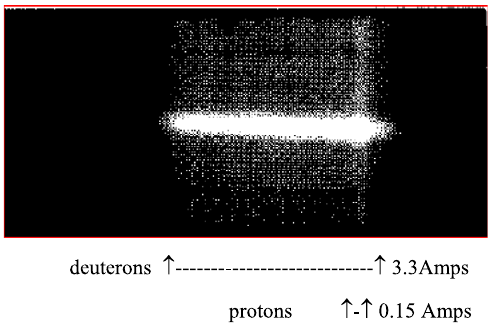
FIG. 21. Photograph taken from the gas curtain showing beams of deuterons and protons circulating in the same ISR ring.